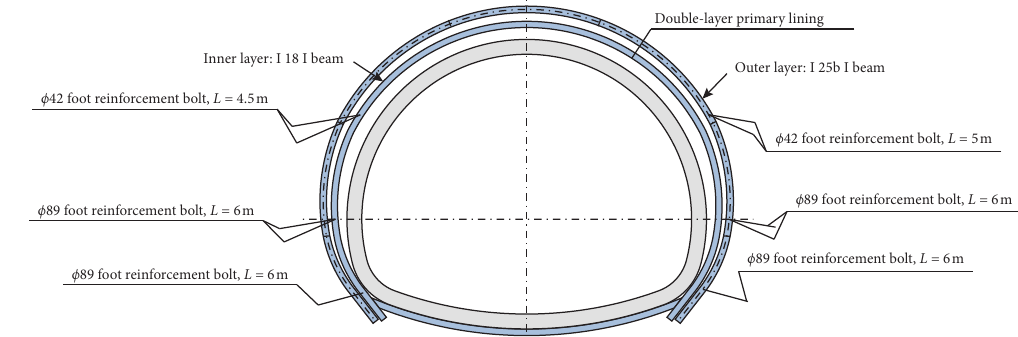
ϕ 42 foot reinforcement bolt, L = 5m